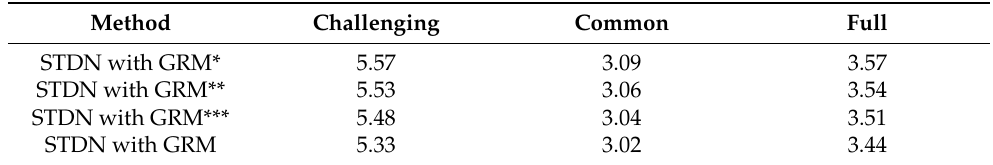
Figure 10. Strategies for dividing face shape into different facial groups. Table 7. Ablation experiments of different group division strategies on 300 W. *, **, *** indicate the results using the different group division strategies as shown in Figure 10.